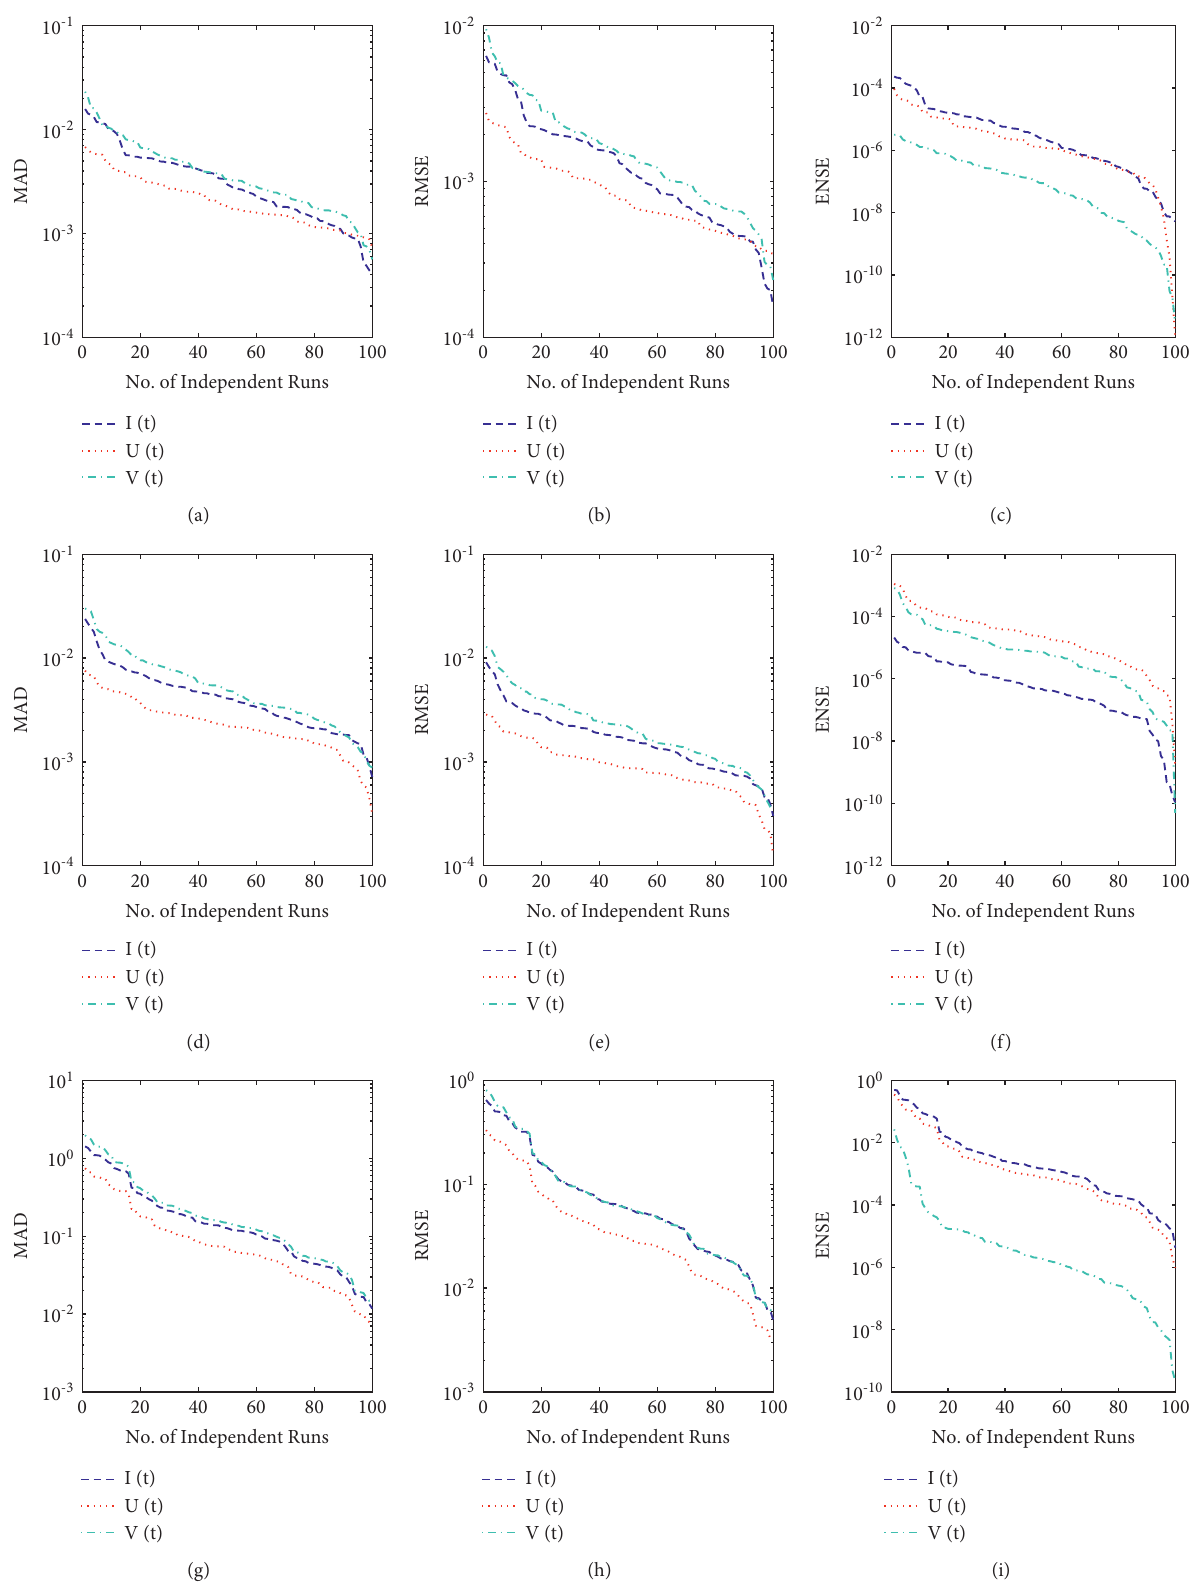
Figure 8: Graphs of performance operators. (a) MAD of problem 1, (b) RMSE of problem 1, (c) ENSE of problem 1, (d) MAD of problem 2, (e) RMSE of problem 2, (f) ENSE of problem 2, (g) MAD of problem 3, (h) RMSE of problem 3, and (i) ENSE of problem